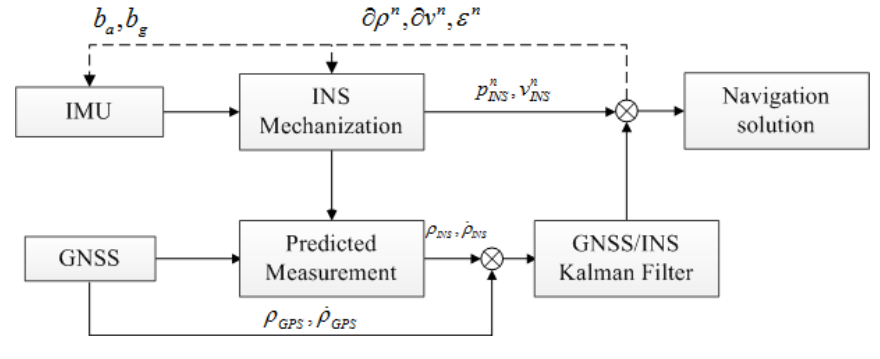
Figure 1. Tightly-coupled integration